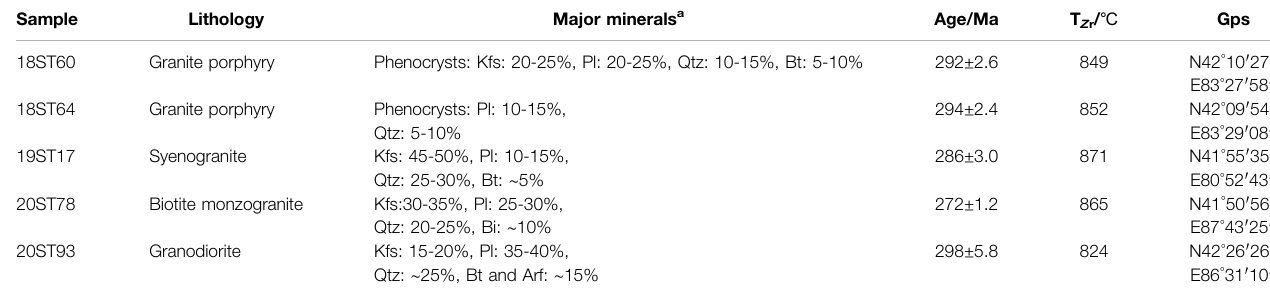
TABLE 1 | Simple petrological descriptions, ages and zircon saturation temperatures of Permian granitoids investigated in this study